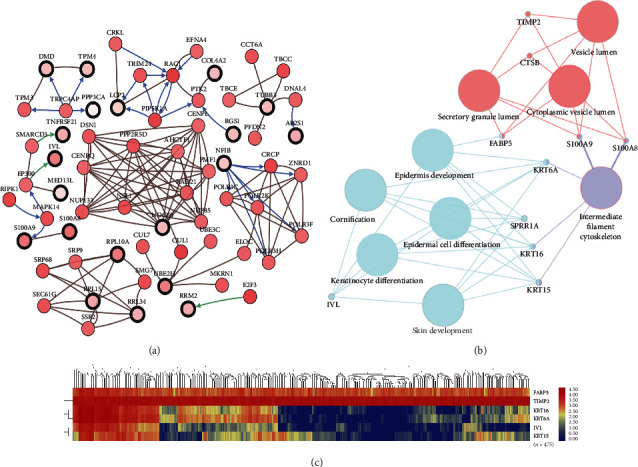
Interaction network and biological process analysis of the hub genes. (a) Hub genes and their coexpression network were analyzed by using cBioPortal. Nodes with bold black outline represent hub genes. Nodes with thin black outline represent the coexpression genes. (b) The biological process analysis of hub genes was constructed by using ClueGO. Different colors of nodes refer to the functional annotation of ontologies. Corrected p value < 0.01 was considered statistically significant. (c) Hierarchical partitioning of 6 significant hub genes was obtained from DNA microarrays (n = 475). It represented the level of expression of 6 genes across a number of comparable samples with high expression samples marked in red and low in blue.